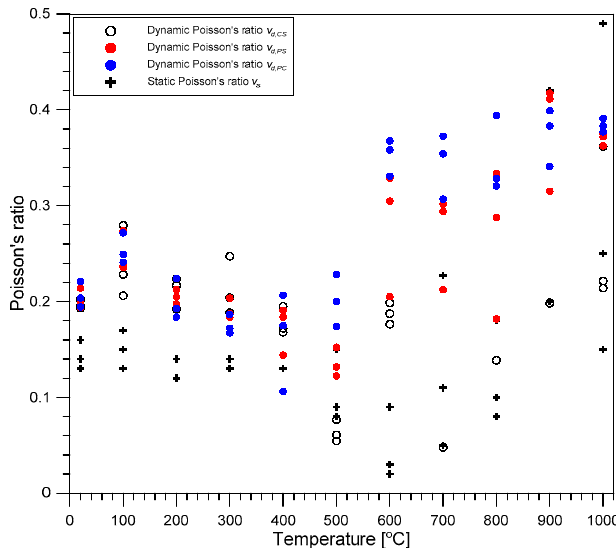
Figure 9. The variation of static and dynamic Poisson’s ratios of concrete with temperature.